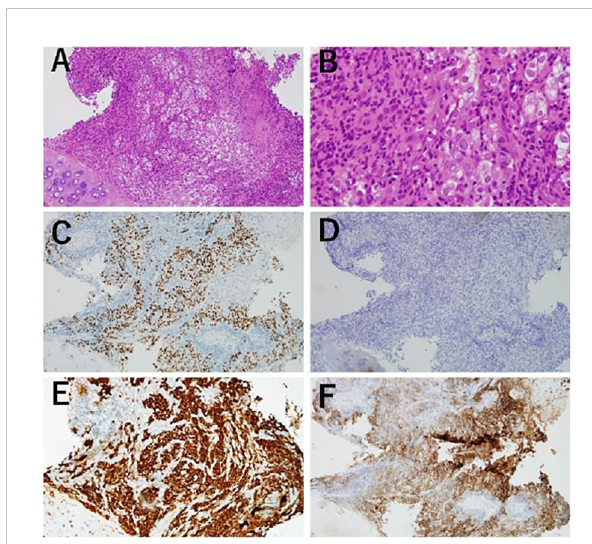
FIGURE 2 Transbronchiallung biopsy before treatment. (A, B) Atypical cell in fi ltration and lymphocyte in fi ltration were observed. (100x, 400x) (C) Tumor cells positive by immunohistochemistry (IHC) for TTF-1. (100x) (D) Tumor cells were negative by IHC for p40. (100x) (E) Tumor cells positive for ALK IHC (Roche-Ventana, D5F3). (100x) (F) PD-L1 IHC (Dako, 22C3), giving a tumor proportion score of 100.